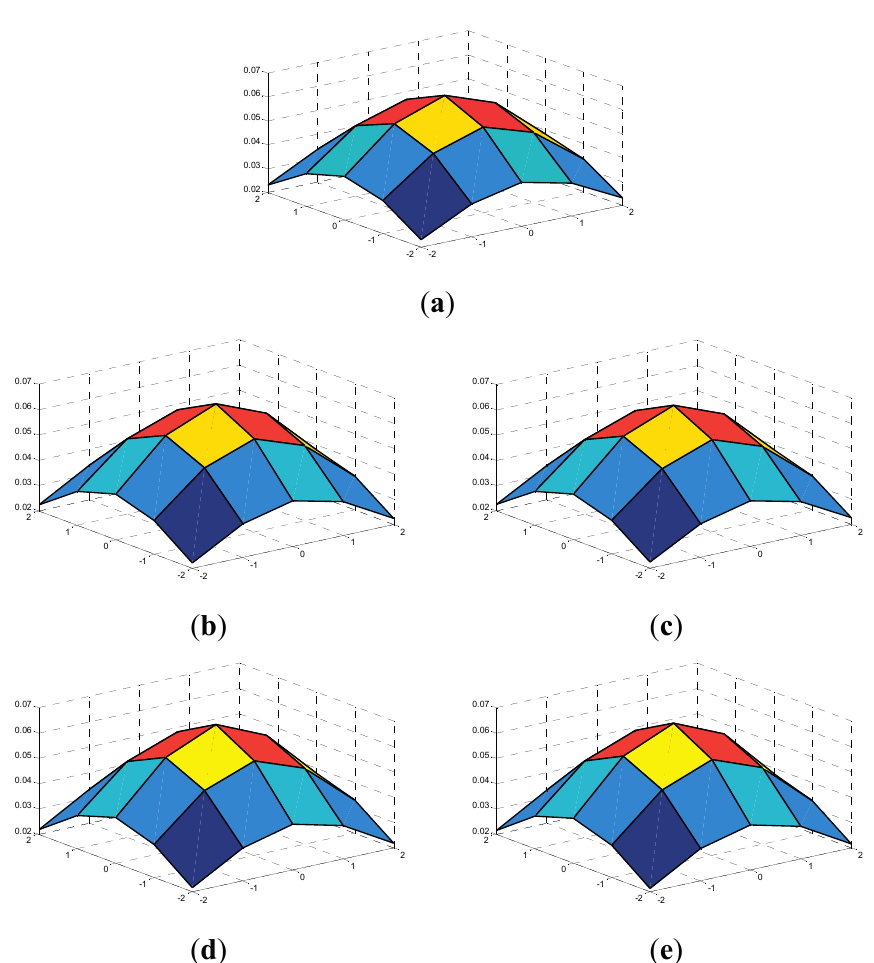
Figure 9. Profiles of the true PSF and the final PSFs of AM-Kedge: ( a ) is the true PSF of Figures 5–8a (a 5 × 5 truncated Gaussian blur with a standard deviation of 2); ( b – e ) are the corresponding final PSFs of Figures 5–8e,